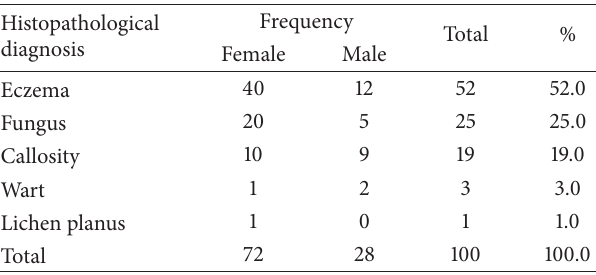
Table 1: Distribution of toe web space lesions in the 100 patients. Table 2: Microbiological findings in the 100 patients.